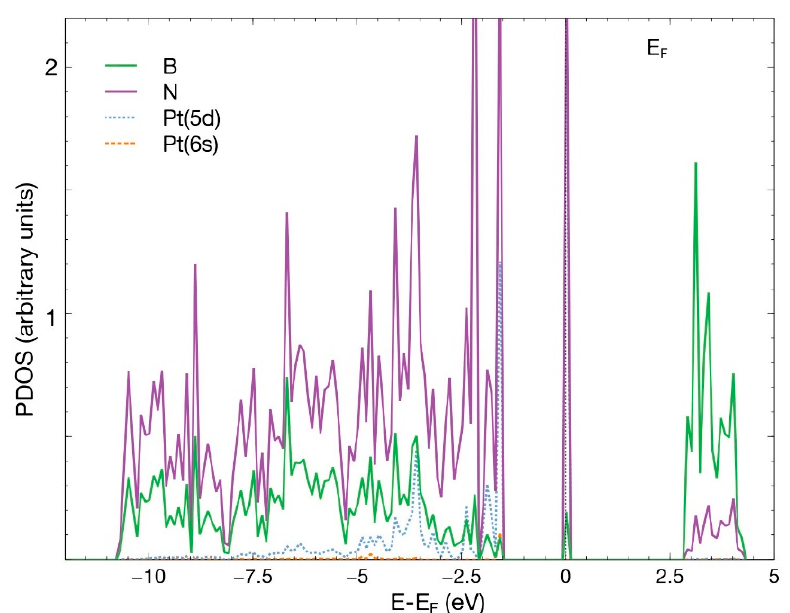
Figure 9. PDOS for the case in which a Pt atom chemisorbs in the vacancy site of an hBN surface with a boron vacancy. This figure presents the p orbitals for boron and nitrogen and the orbitals 6s and 5 d for Pt.